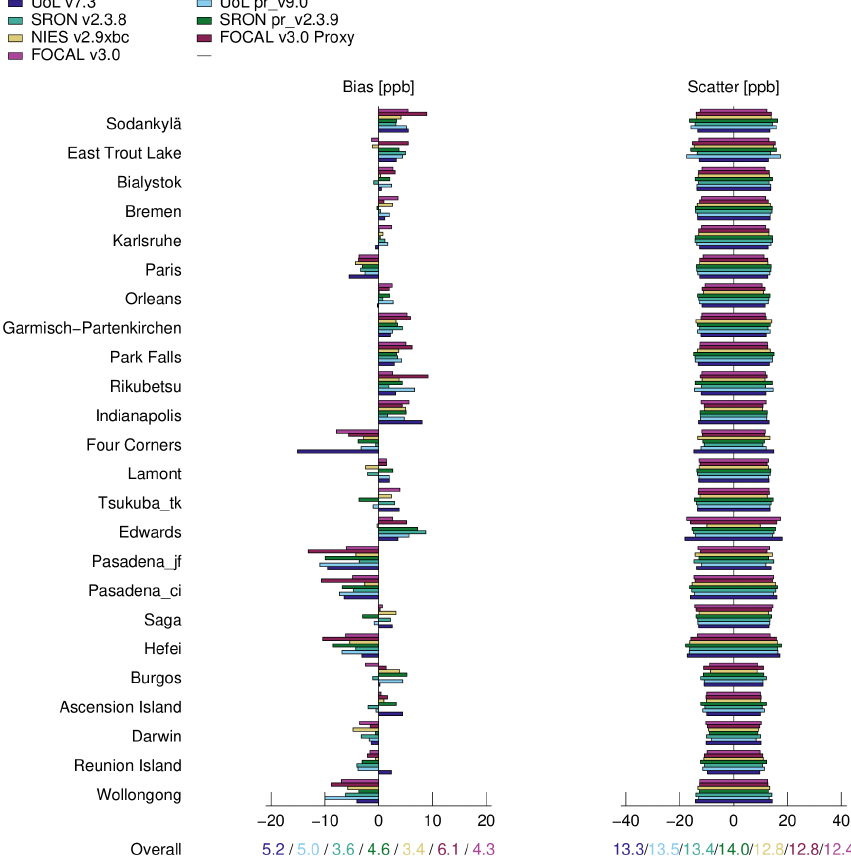
The derived seasonal bias is low (0.33 ppm for